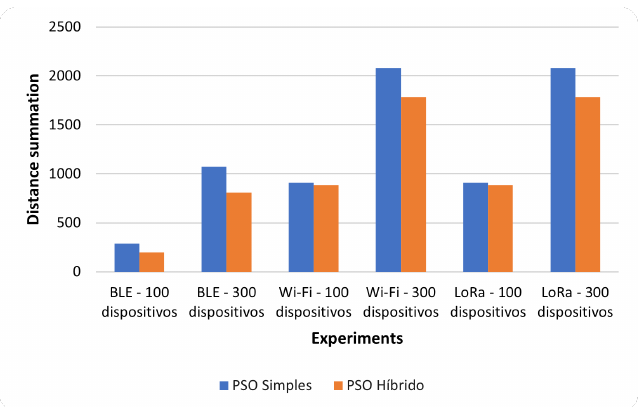
Figure 13. The comparison of the total distances between the IoT devices and their gateways using the simple and hybrid PSO